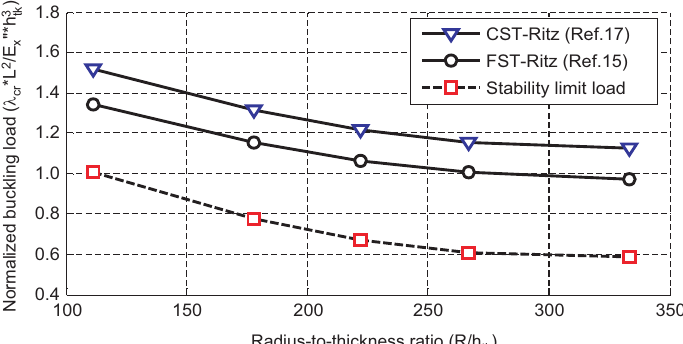
Figure 8 Variation of linear buckling and stability limit loads with the change of radius-to-thickness of the clamped-clamped hybrid laminate . with lay-up confi guration LC 3